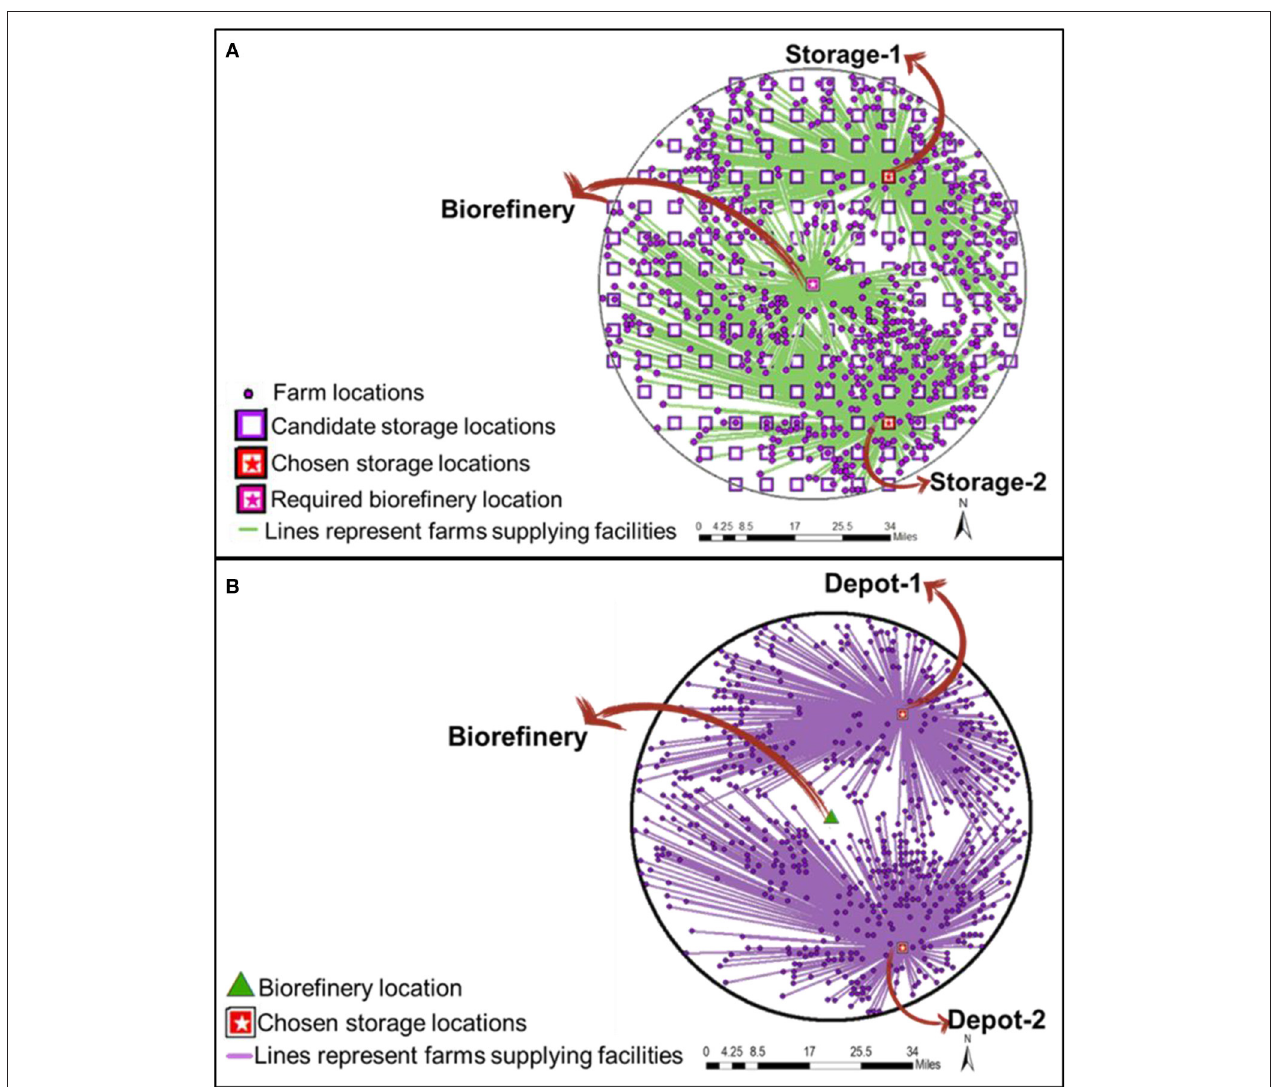
FIGURE 5 | Location-allocation model (A) Farms associated with supplying corn stover to storage sites and biorefinery; (B) Farms associated with supplying corn stover to